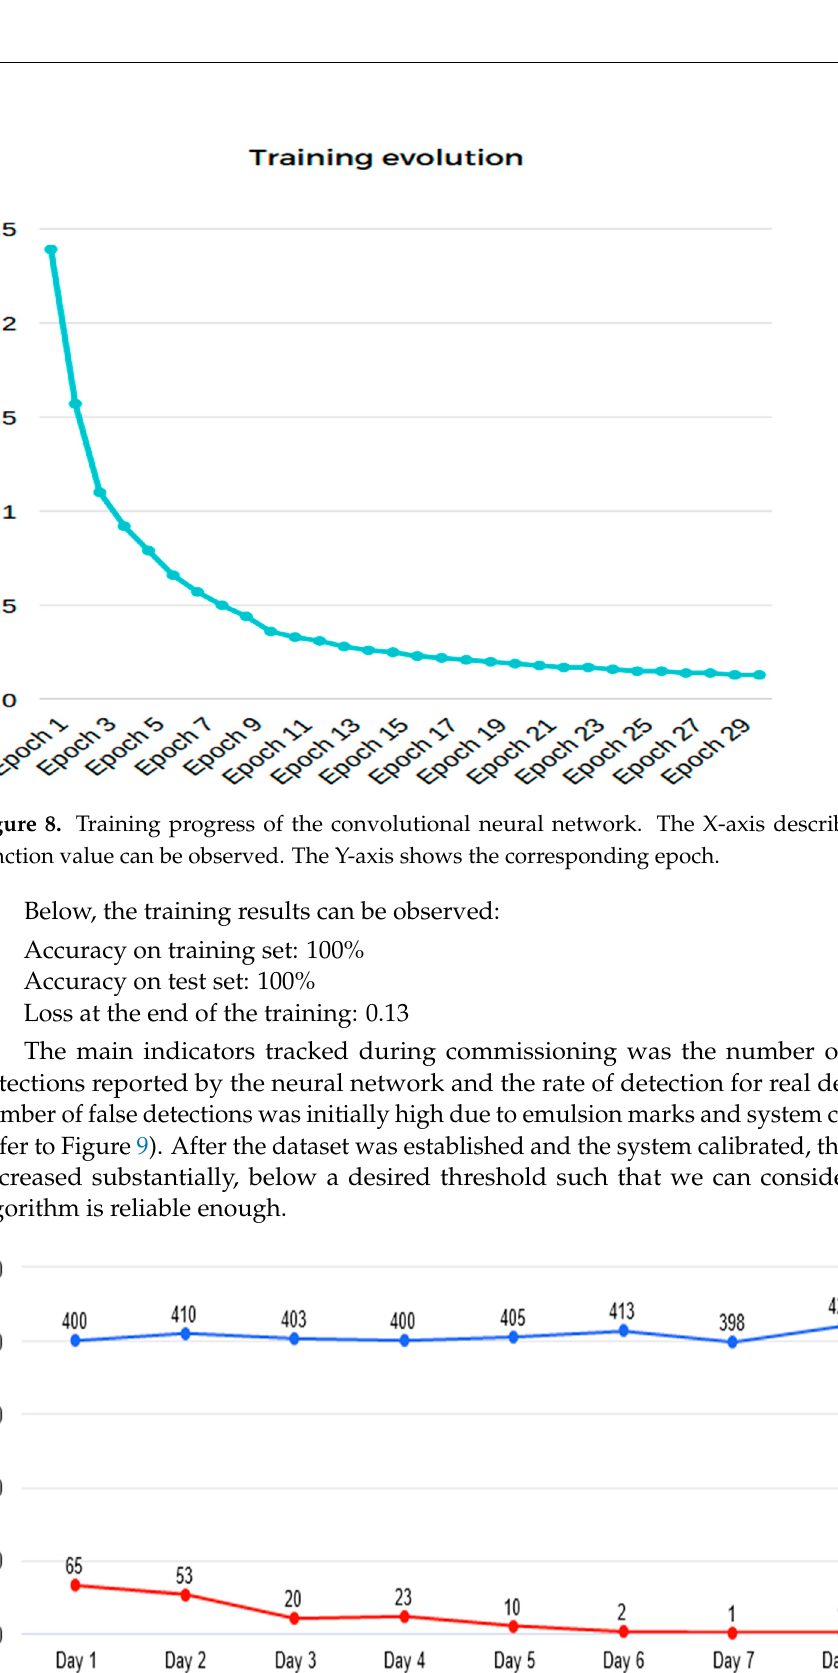
Figure 9. Evolution of false detections.